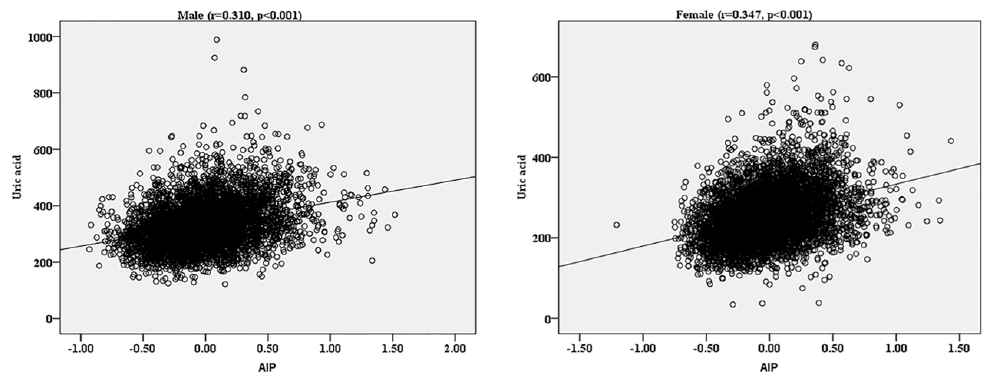
Figure 1. Spearman rank correlation of AIP with UA by sexes. AIP: atherogenic index of plasma; UA, uric acid.